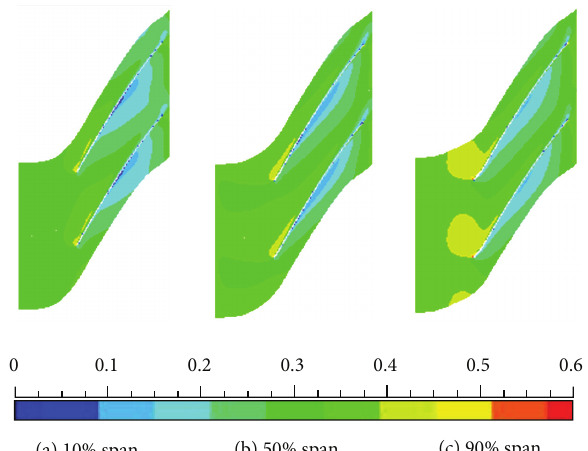
Figure 14: Static pressure distribution.